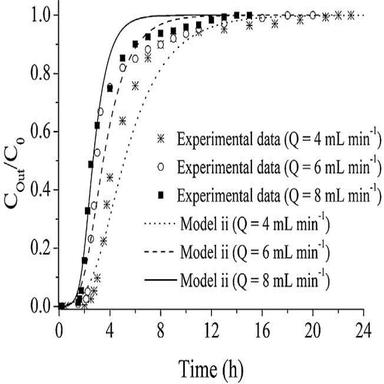
Breakthrough curves to analysis of influence of feed flow rate in the mass transfer coefficient: experimental and simulated by model ii.